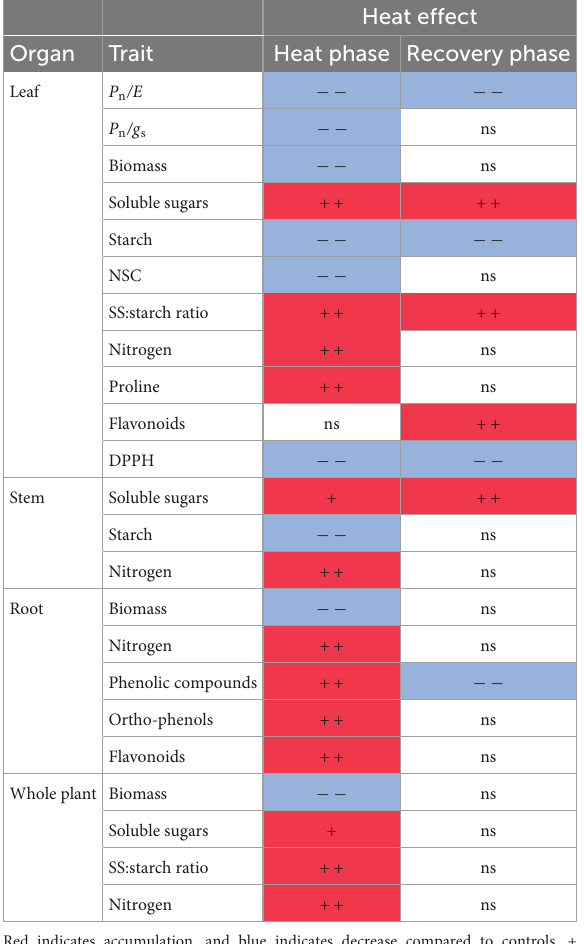
depends on climate origin During the heat phase, no interpopulation differences were observed in external symptoms and foliar damage. However, seedlings from the northern population were the most adversely affected by heat stress in terms of biomass reduction in